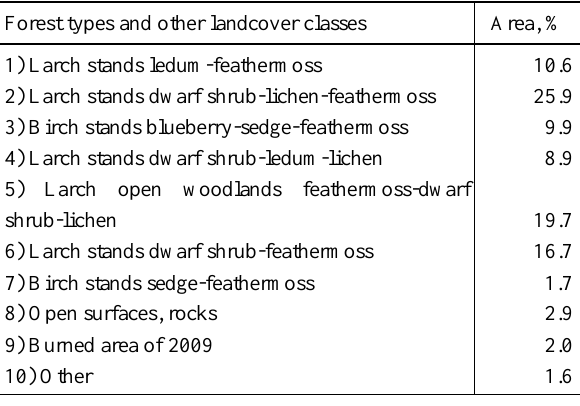
Table 1. Classes present on the test